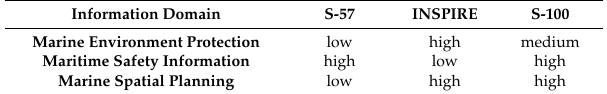
Table 4. Marine data model standards relevance to the marine information